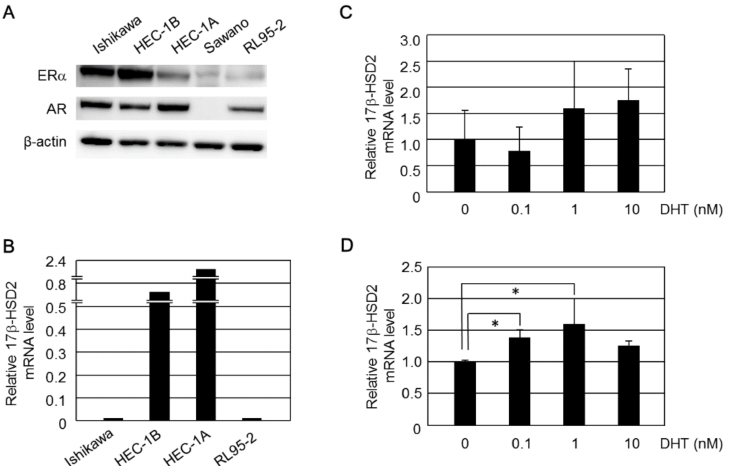
( p < 0.001) (Figure 2A). The effect of DHT treatment on 17 β -HSD2 mRNA induction was significantly inhibited by co-treatment with 1 µ M bicalutamide ( p < 0.001, Figure 1A). Bicalutamide (1 µ M) alone did not significantly change 17 β -HSD2 mRNA levels in HEC-1B cells (data not shown). In Western blot analysis, relatively high levels of 17 β -HSD2 immunoreactivity were detected in HEC-1B cells treated with 1 nM and 10 nM DHT. The induction of 17 β -HSD2 immunoreactivity was inhibited by 1 µ M bicalutamide treatment (Figure 2B).